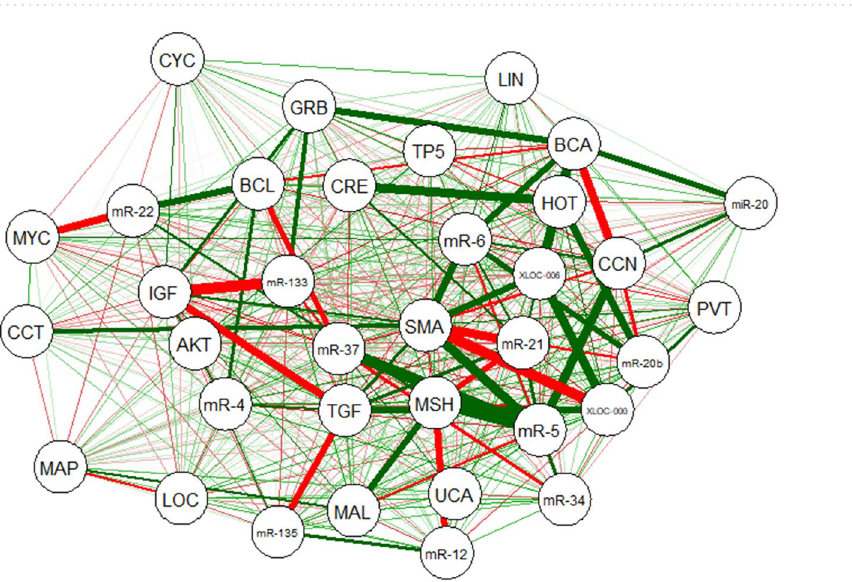
Figure 9. ceRNA regulatory network of lncRNAs, miRs, and mRNAs in rectal cancer. Red lines indicate a negative correlation, and green lines indicate a positive correlation. The figure was created using the R software: R Core Team (2019), R Foundation for Statistical Computing, Vienna, Austria. URL https:// www.R- proje ct. org/. PVT: PVT1, HOT: HOTAIR, MAL: MALAT1, UCA: UCA1, CCT: CCAT1, CRE: CRNDE, XLOC_006: XLOC_006844, LOC: LOC152578, XLOC-000: XLOC-000303, BCA: BCAR4, LIN: LincRNA-P21, MAP: MAPK11, AKT: AKT3, MYC: MYC, BCL: BCL2, GRB: GRB10, IGF: IGF1, SMA: SMAD4, CCN: CCND1, CYC: CYCS, TGF: TGFBR2, MSH: MSH2,TP5: TP53, mR-21: miR-21, mR-20: miR-20a, mR-20b: miR-20b, mR-4: miR-424, mR-12: miR-1244, mR-135: miR-135b, mR-22: miR-224, mR-37: miR-378a, mR-5: miR-548ac, mR-34: miR-34a, mR-133: miR-133b, mR-6: